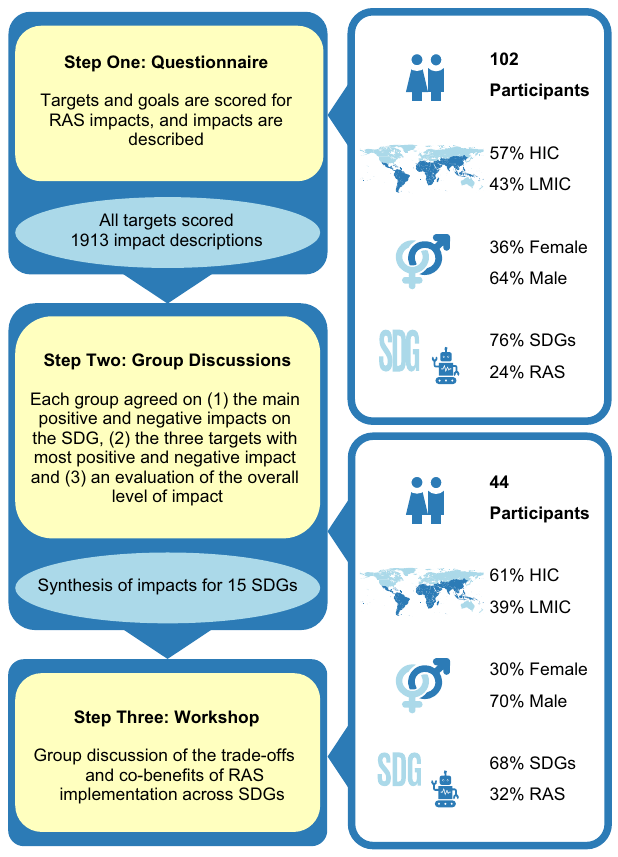
Fig. 2 Horizon scan process used to identify the opportunities and threats from robotics and autonomous systems (RAS) deployment for the Sustainable Development Goals (SDG). The horizon scan comprised of a three steps process including an online questionnaire, a group synthesis exercise and a workshop. HIC high-income countries, LMIC low- and middle-income